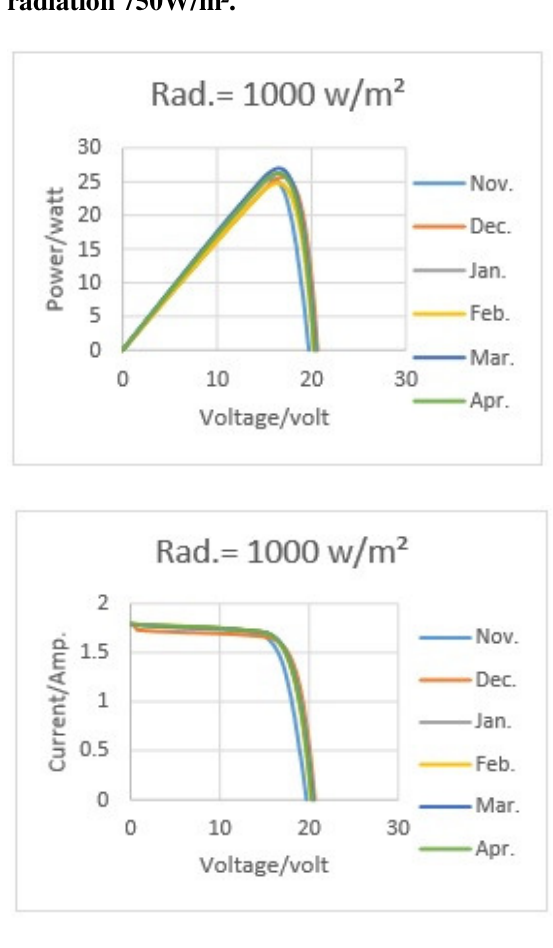
Fig. 6. P-V and I-V characteristic of monocrystalline PV solar cell at constant radiation